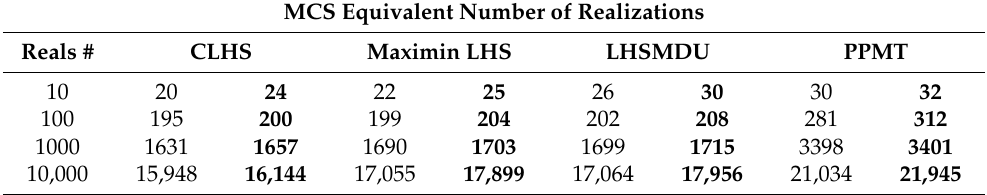
Table 4. The equivalent number of realizations to be generated by MCS ensuring the specified sampling